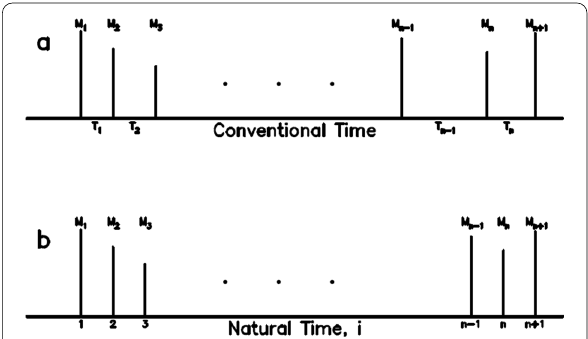
Fig. 1 Earthquake sequences: a displayed in the conventional time (The vertical line segments denote the magnitudes and occurrence times of earthquakes, with a time interval, T i ( i 1, 2, …, n), between = successive events i and i 1; and b represented in the natural time, + i.e., the count, i , of an